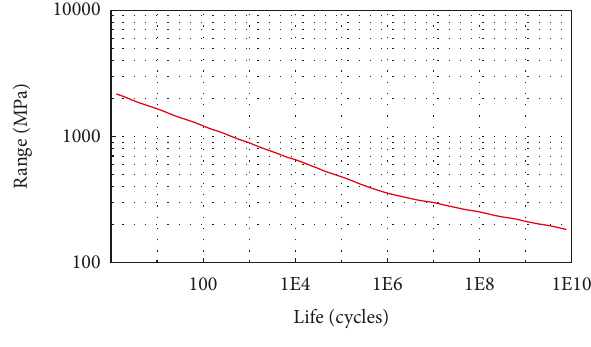
Figure 15: S-N curve of DL510.